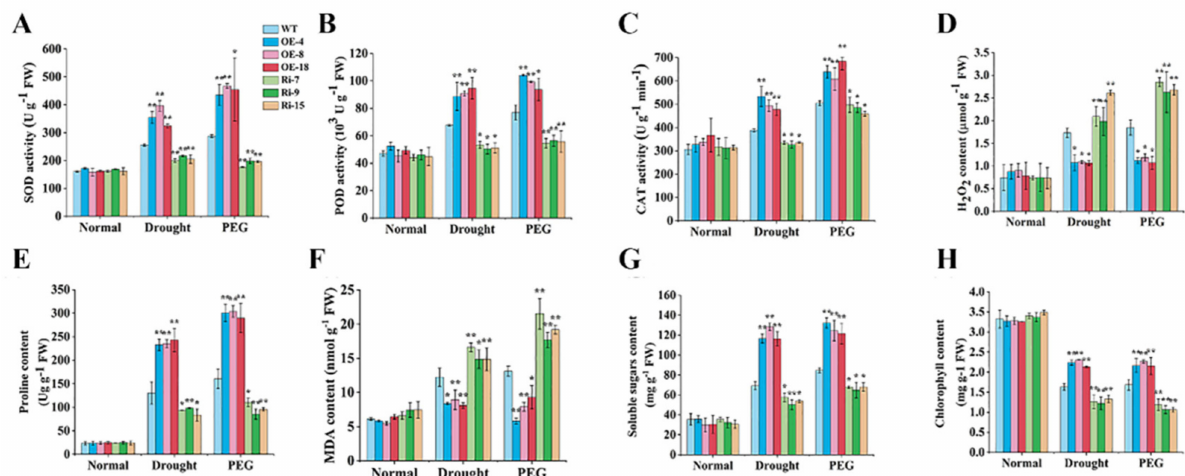
Figure 5. Analysis of physiological indices of transgenic and WT potato plants under drought and PEG6000 treatment. ( A ) SOD activity, ( B ) POD activity, ( C ) CAT activity ( D ) H 2 O 2 content, ( E ) proline content, ( F ) MDA content, ( G ) soluble sugars content and ( H ) chlorophyll content in leaves. Experiments were repeated three times independently. Data are mean ± SD ( n = 3 ). Significance compared with the no-stress treatment was determined using the ANOVA Duncan’s test; p < 0.05, significant (*); p < 0.01, highly significant